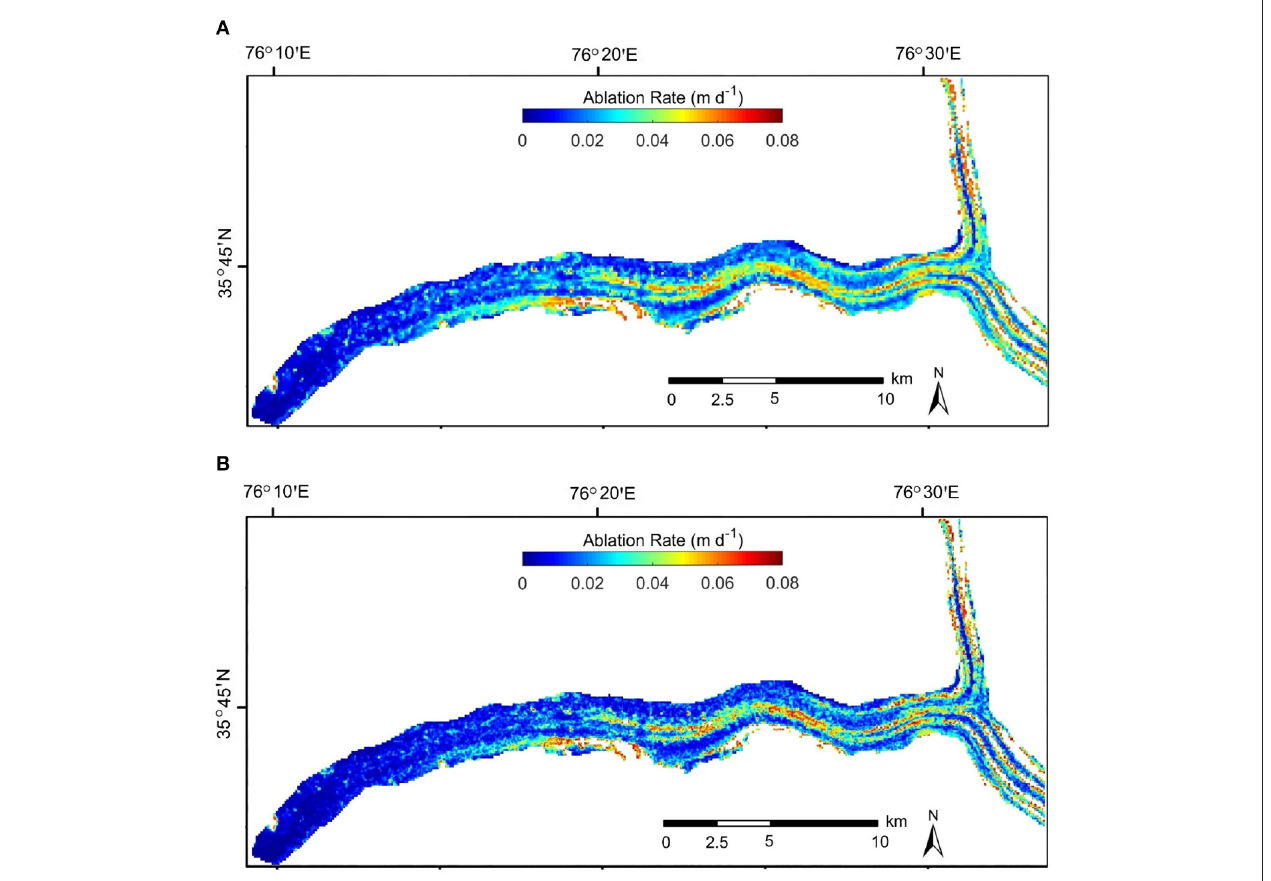
FIGURE 7 | Surface ablation rates for the Baltoro Glacier modeled with two different methods: (A) The remote-sensing based approach (Mihalcea et al., 2008), which uses surface temperature data acquired by satellite. (B) The surface energy balance based approach, which uses modeled surface irradiance. Both results are based on the same debris thickness distribution, assuming no water bodies and were produced to represent rates on August 14 2004. Note the high spatial variability in ablation rate caused by the debris thickness distribution ( Figure 5A